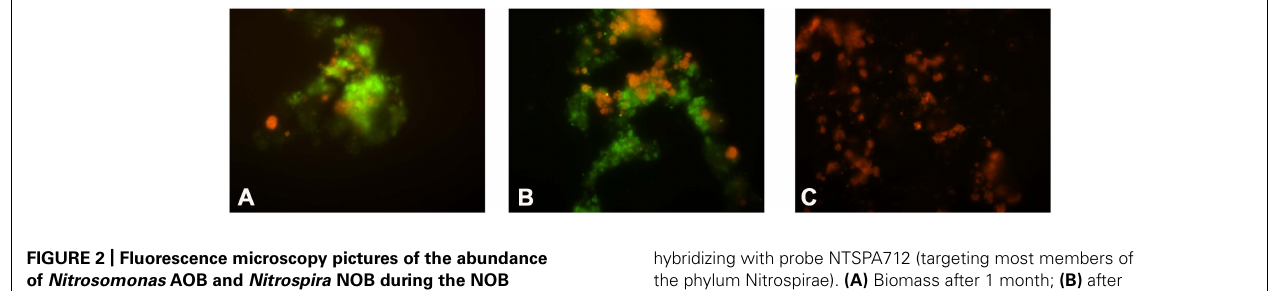
hybridizing with probe NTSPA712 (targeting most members of the phylum Nitrospirae). (A) Biomass after 1 month; (B) after 3 months; (C) after 6 months of operation with nitrite as the only